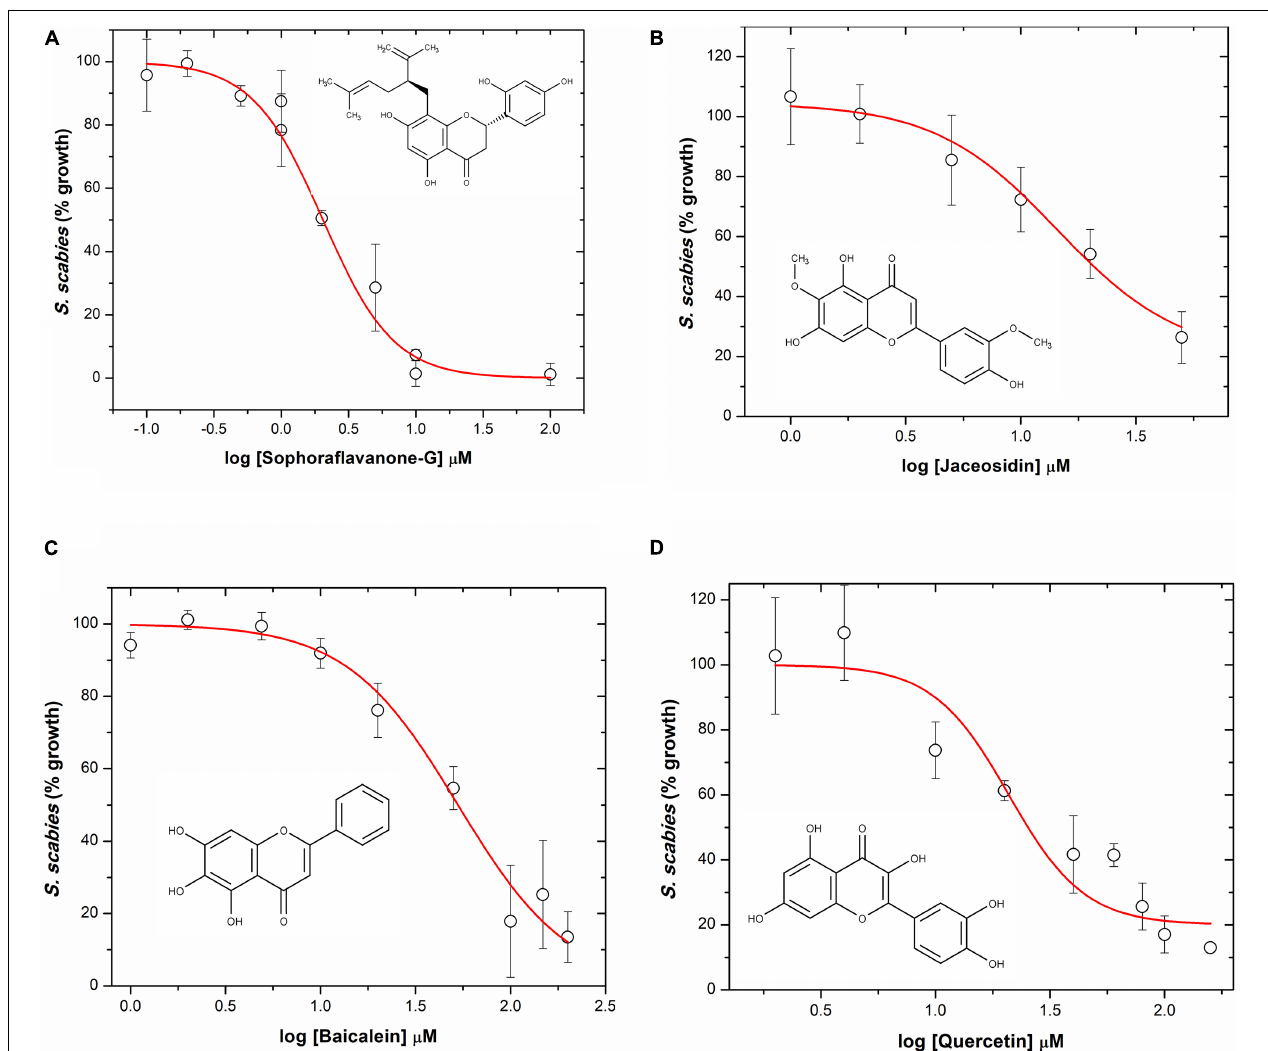
FIGURE 3 | S. scabies dose-response growth curves in the presence of flavonoids. (A) Sophoraflavanone G. (B) Jaceosidin. (C) Baicalein. (D) Quercetin. The chemical structure of each flavonoid is shown for its corresponding dose-response curve. A S. scabies starter culture was grown to an A 660 nm of 0.18, then 20 µ L aliquots of the starter culture were used to inoculate 1 mL nutrient broth with 4% DMSO, flavonoid at various concentrations, and a metal spring for shearing. Cultures were grown by shaking at 250 rpm at 30 ◦ C for 7 h. Afterwards, the level of growth was determined with the MBA. LD 50 and MIC data were calculated via a dose response model in OriginPro ver8. Each measurement represents the mean of triplicate experiments ± standard deviation of the mean.